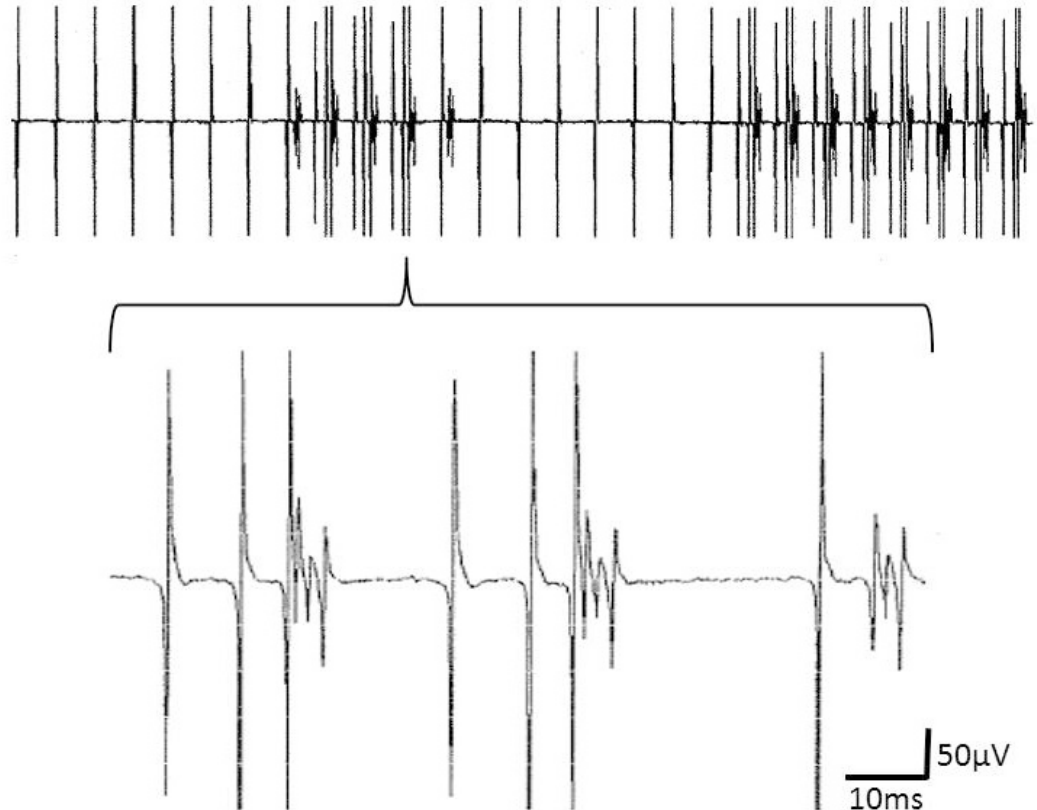
Figure 4. Upper part: complex repetitive discharges (CRD) that alternate with a fibrillation potential that takes part in the CRD, presumably as its pacemaker. The lower part shows the CRDs in an enlarged window.